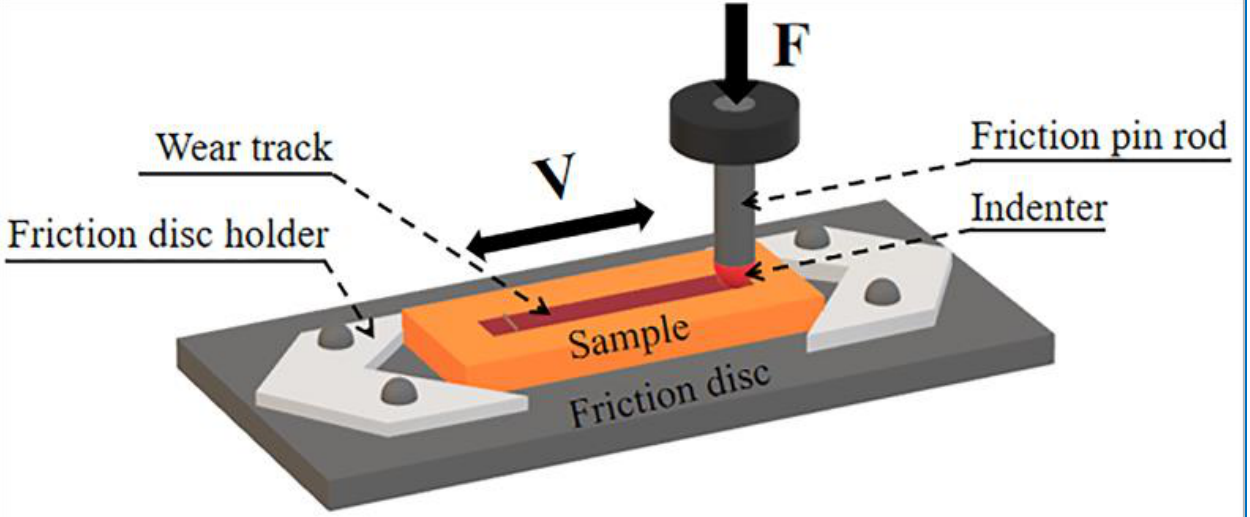
Figure 2. Schematic of the friction test.